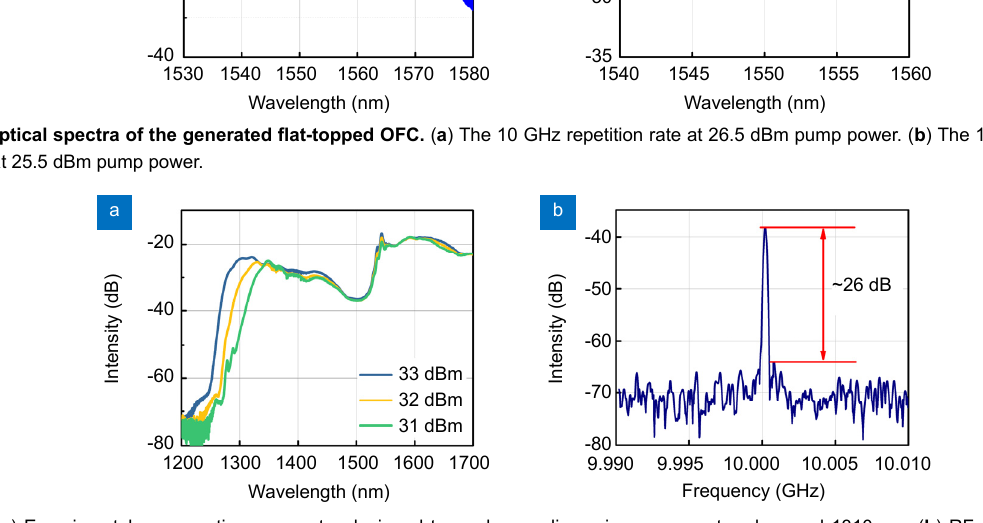
Fig. 5 | ( a ) Experimental supercontinuum spectra designed to produce a dispersive wave centered around 1310 nm. ( b ) RF spectra from the generated 1310 nm dispersion wave at 32 dBm pump power (RBW=200 kHz and VBW=50 kHz).